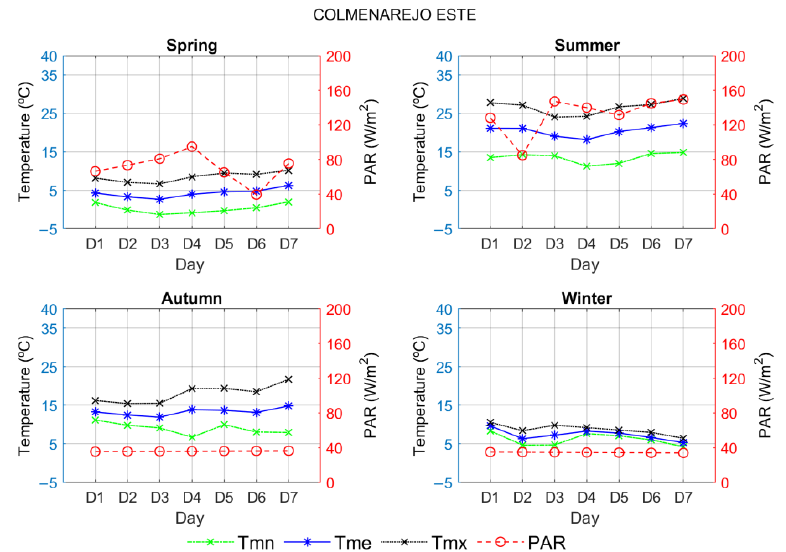
Figure 2. Daily variations of the daily mean values of temperature (mean, maximum, and minimum) and PAR for the selected TMWs for each season in Colmenarejo Este from 1991 to 2005. The daily mean values of the TMW parameters for each season were obtained, and the variability of some parameters was plotted, which is illustrated in Figure 2, showing the daily variation of the mean values of PAR and temperature indices for the different